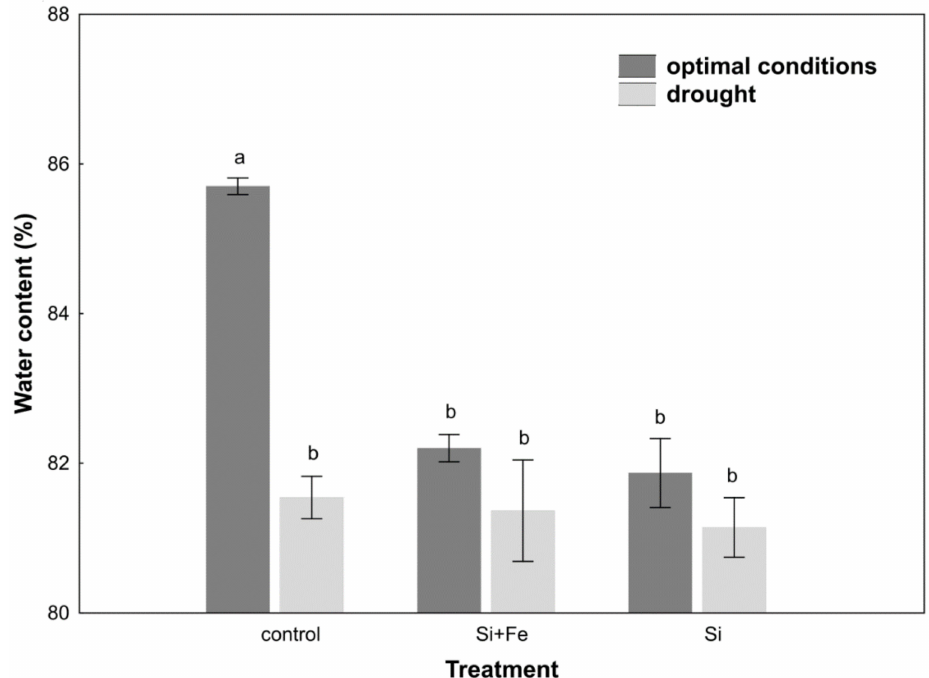
Figure 2. Water content in leaves of oilseed rape. Plants grew first for 44 days under optimal conditions and were watered three times with water (control), silicon and iron (Si + Fe), or only silicon (Si), and afterwards for 10 days under optimal conditions or drought, after which water content measurements were performed (Experiment 2). The means (n = 9) ± SD marked with the same letter do not differ significantly (Duncan’s multiple range test, p < 0.05).